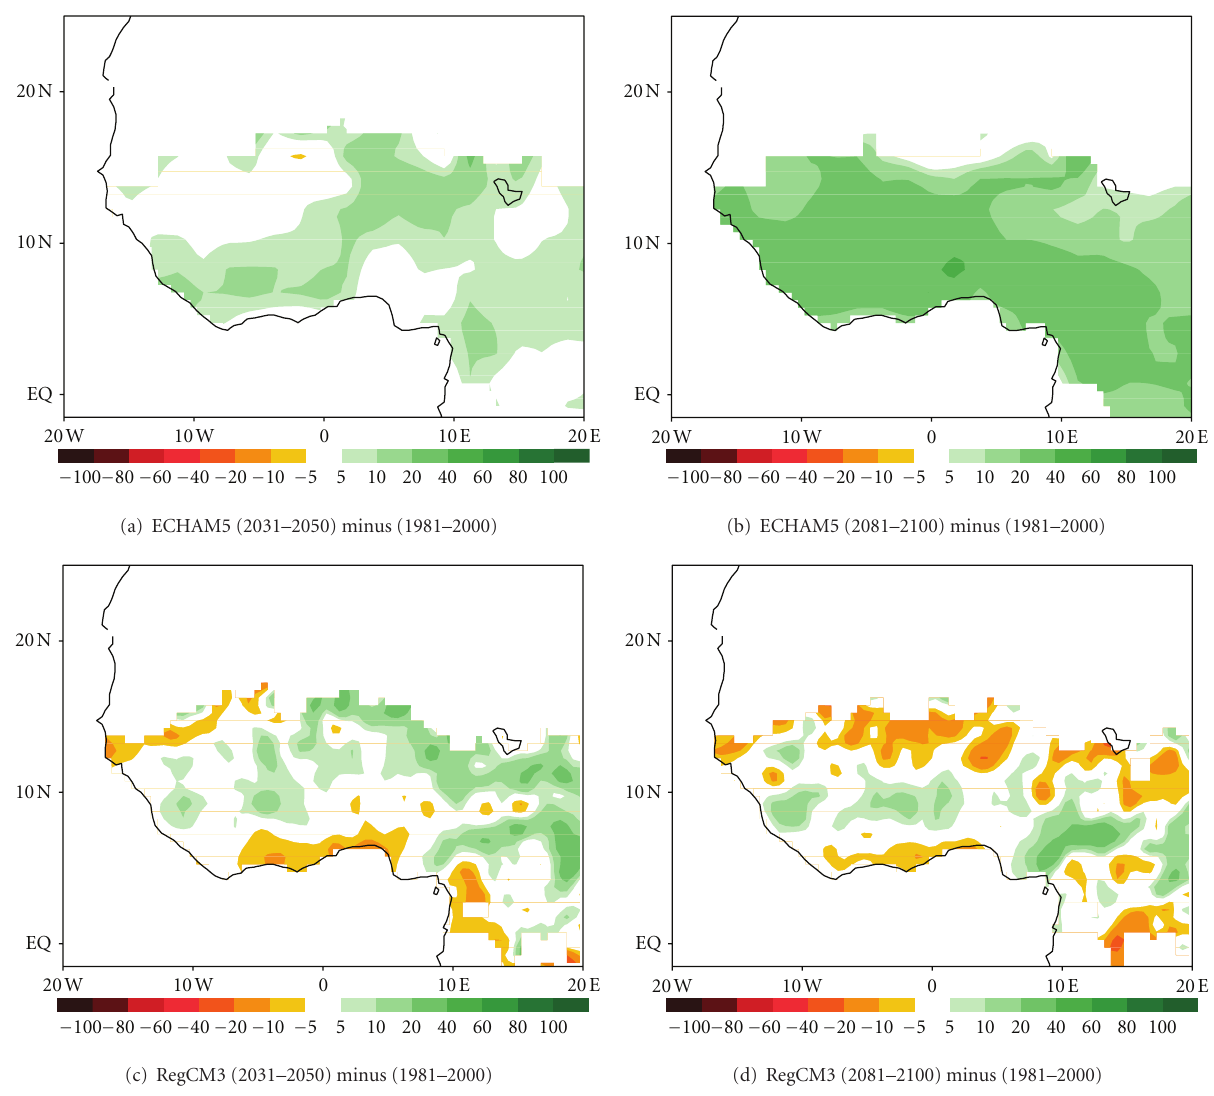
Figure 7: Same as Figure 6 but for the intensity of wet